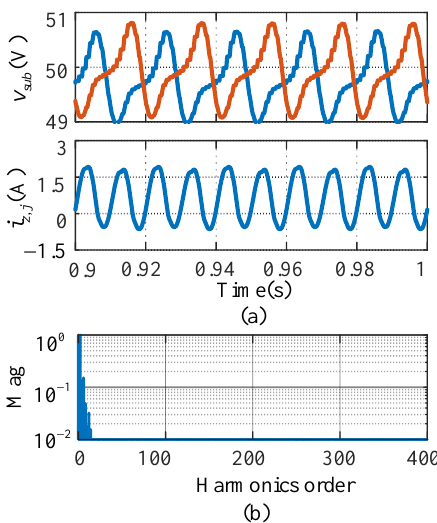
Figure 17. Simulation results of PSC4. ( a ) Capacitor voltage of SMs and circulating current. ( b ) FFT analysis of circulating current.